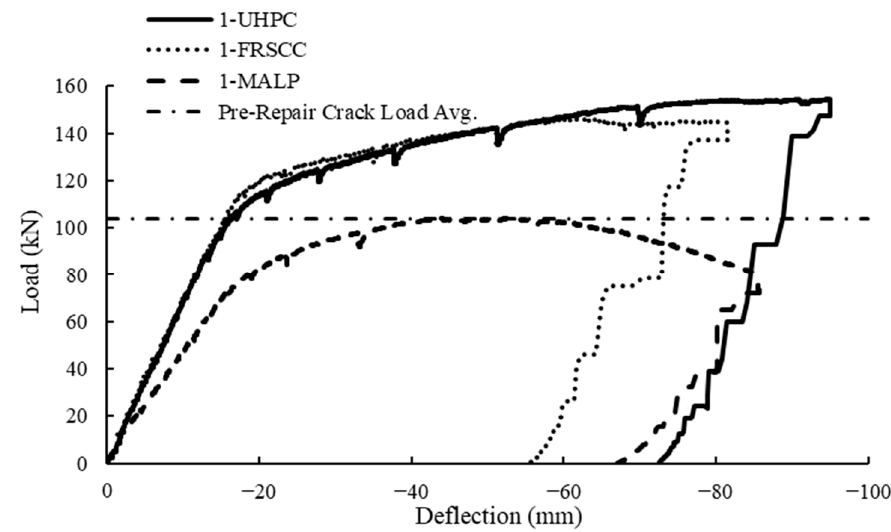
Figure 7. Load vs. deflection plots for all repairs subjected to positive bending.